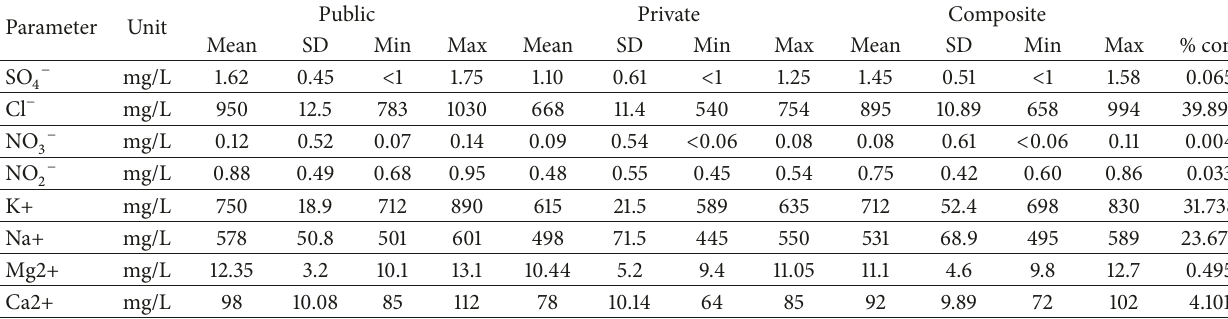
Table 3: Summary results for ionic composition of the faecal sludge.